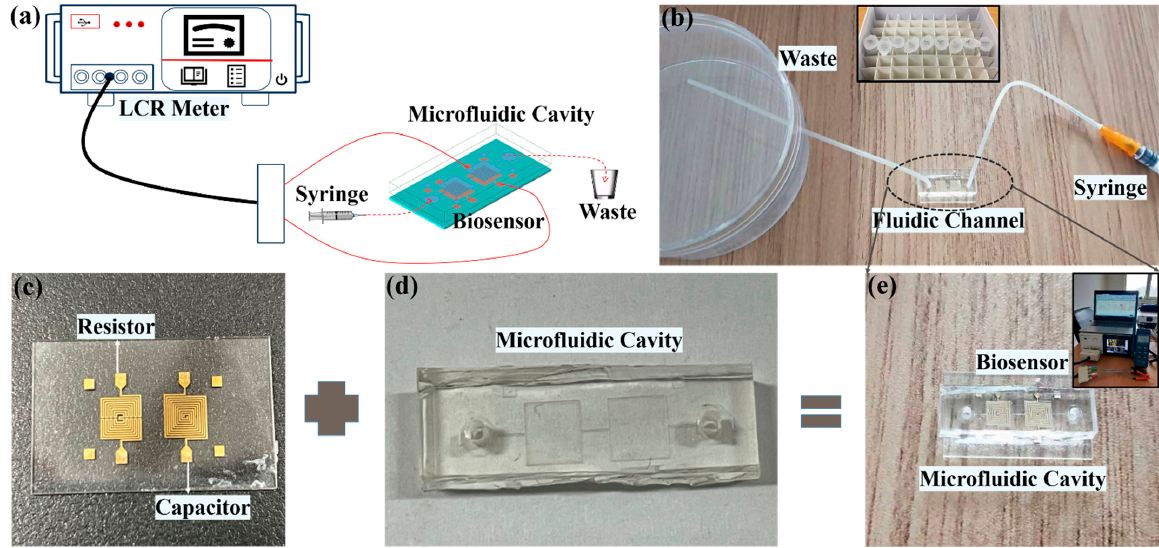
Figure 3. ( a ) Schematic diagram of the sensor and experimental setup; ( b ) measurement view of the solution injected into the microfluidic channel, the inset image is glucose sample; ( c ) fabricated sensor with metal structure; ( d ) fabricated PDMS microfluidic channel; ( e ) proposed sensors integrated with microfluidic channel, inset image is the LCR meter that records the experimental data.